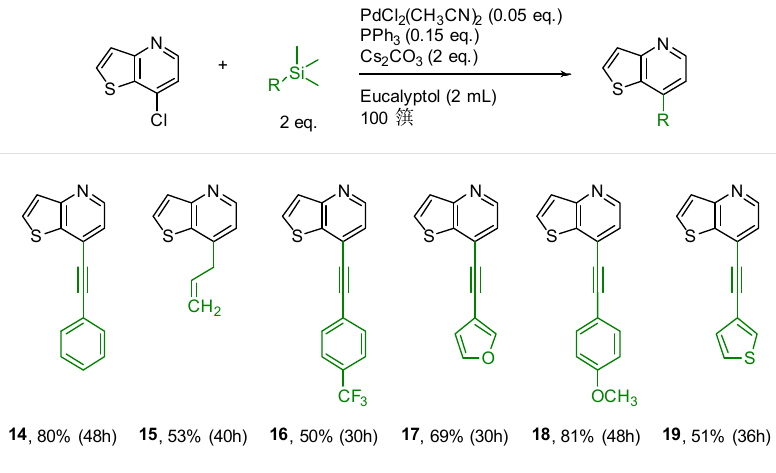
Figure 6. Scope and limitations of the Hiyama coupling from 7-chlorothieno[3,2- b ]pyridine.